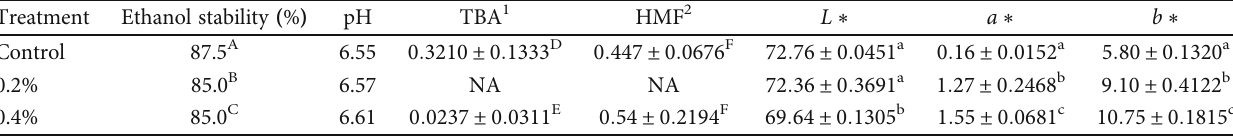
Table 2: E ff ect of Gac aril extract on alcohol stability, color index, TBA, and HMF values of sterilized milk. Treatment